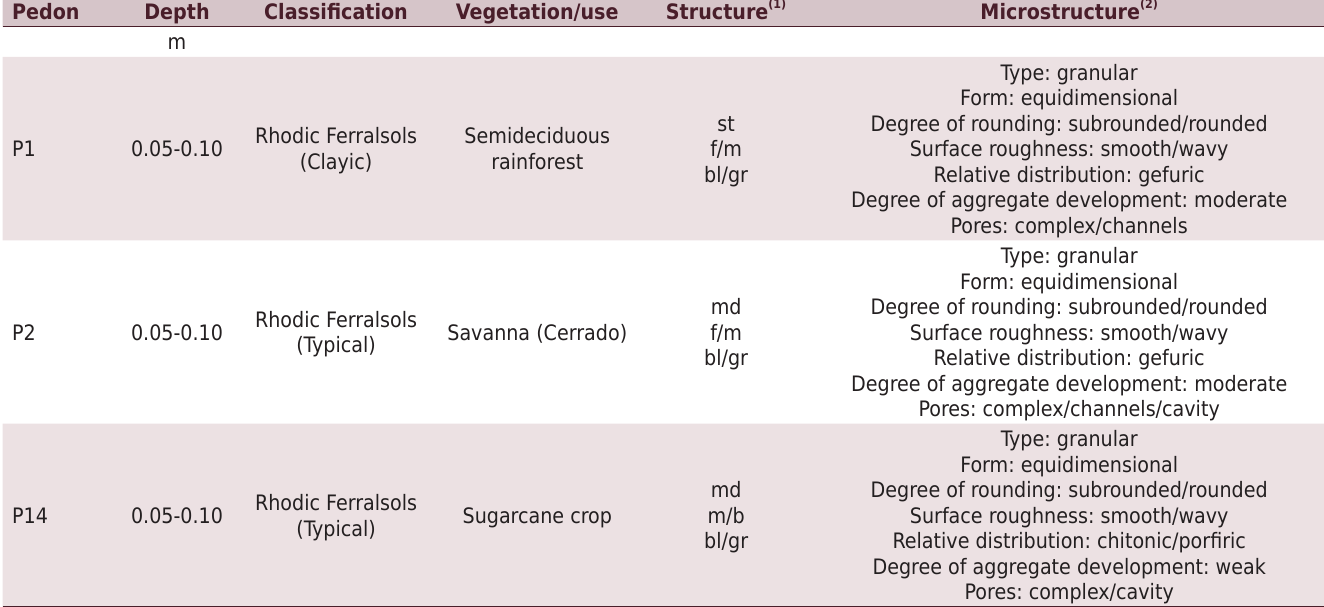
(1) Development: md = moderate, and st = strong; Size: f = fine, m = medium, and b = big; Type: gr = granular and bl = blocky. (2) According to Stoops (2003) and Stoops et al.